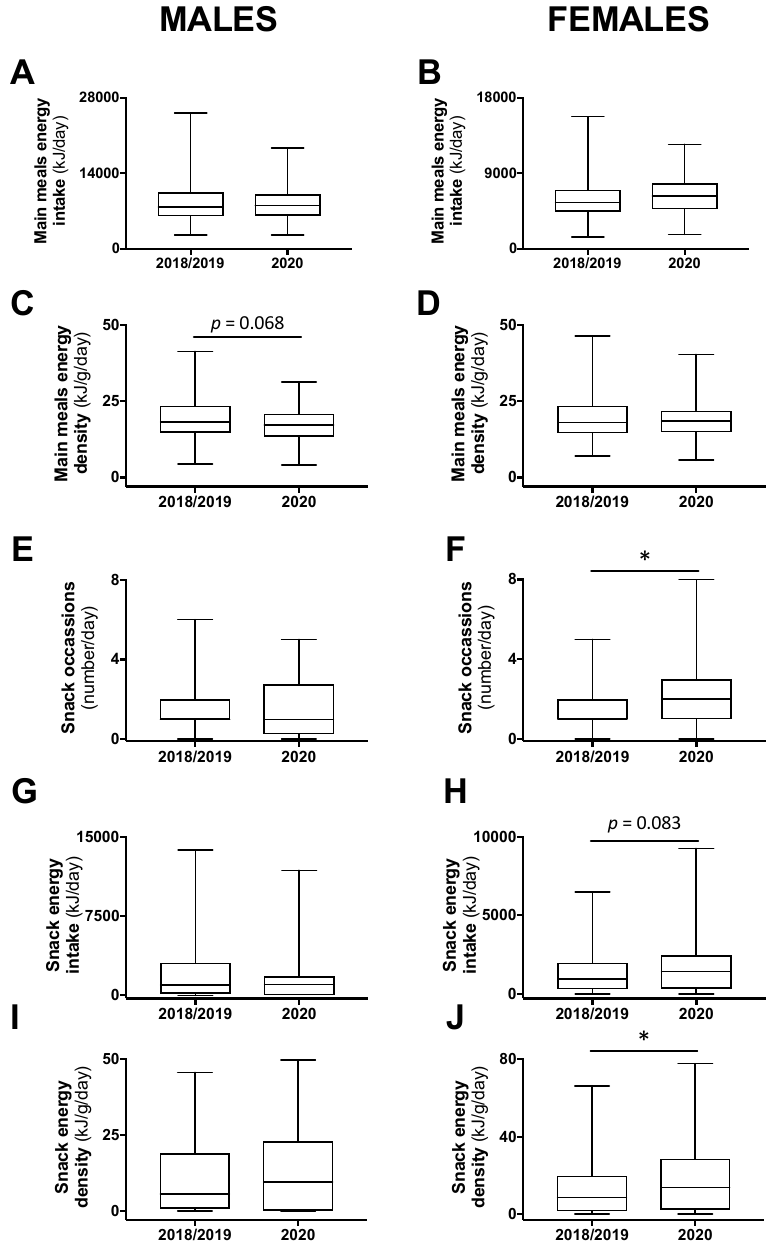
Figure 2. The 24-h energy intake and energy density attributed to main meals ( A – D ) or snacks ( E – H ), and snacking frequency ( I , J ) in male and female students in class year 2020 ( n = 64 males, 82 females) compared with 2018 / 2019 ( n = 128 males, 197 females). No statistical di ff erences were observed between 2018 and 2019 and, therefore, these years were combined. Data are presented as median ± IQR and range. * p < 0.05 between 2020 and 2018 / 2019 by Mann–Whitney test. The proportion of participants who consumed any alcohol between the class years was not di ff erent for males (19% average across all years, p = 0.317) or females (13% average across all years, p = 0.180; data not shown).